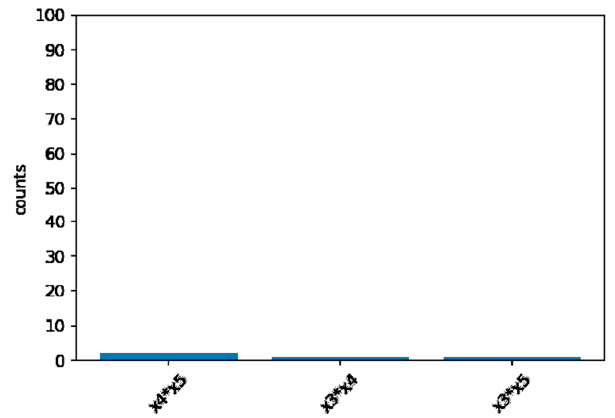
Figure 3. The null distribution of the XGB-FI.